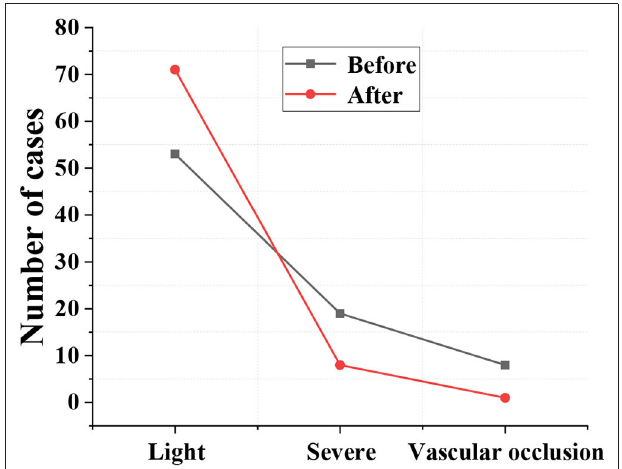
FIGURE 7 | Degree of arterial stenosis.